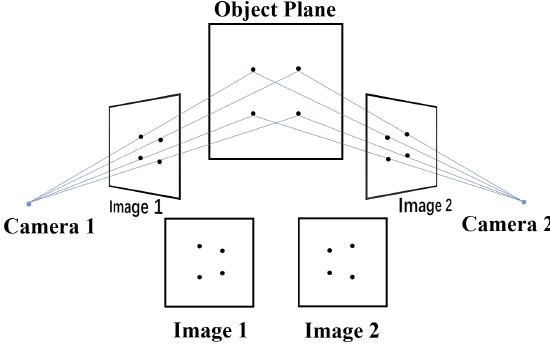
Figure 4. The sketch of online calibration of digital camera for